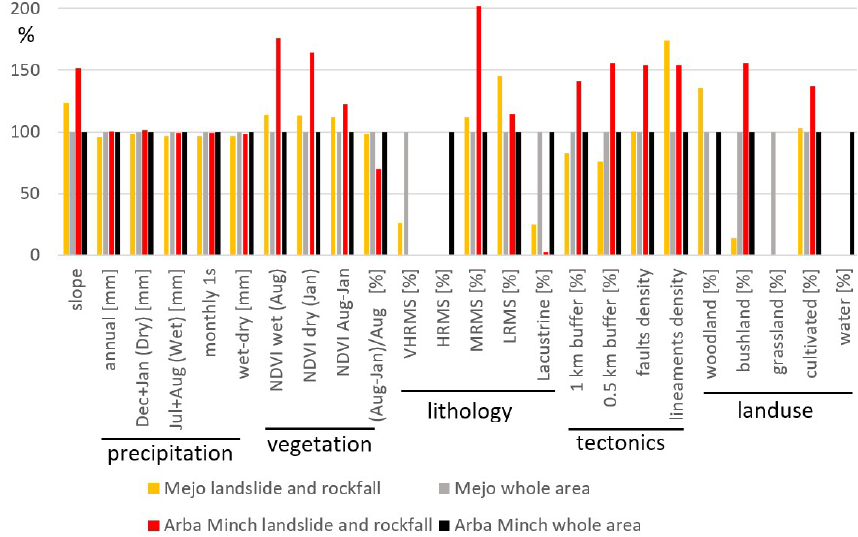
Figure 10. Plot of mean values of particular factors occurring across merged polygons of landslides and rockfalls normalized to the mean value for the overall area. Mejo and Arba Minch sites evaluated